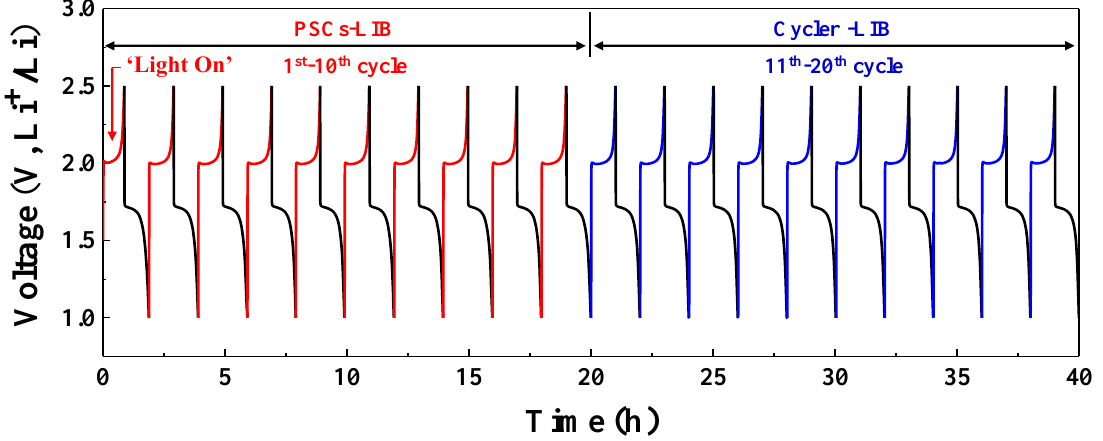
Figure 9. Phtotocharging and discharging diagram of the LFP-LTO cell using PSCs (from cycles 1 to 10) and direct current (DC) charging and discharging using the cycler (from cycles 11 to 20).